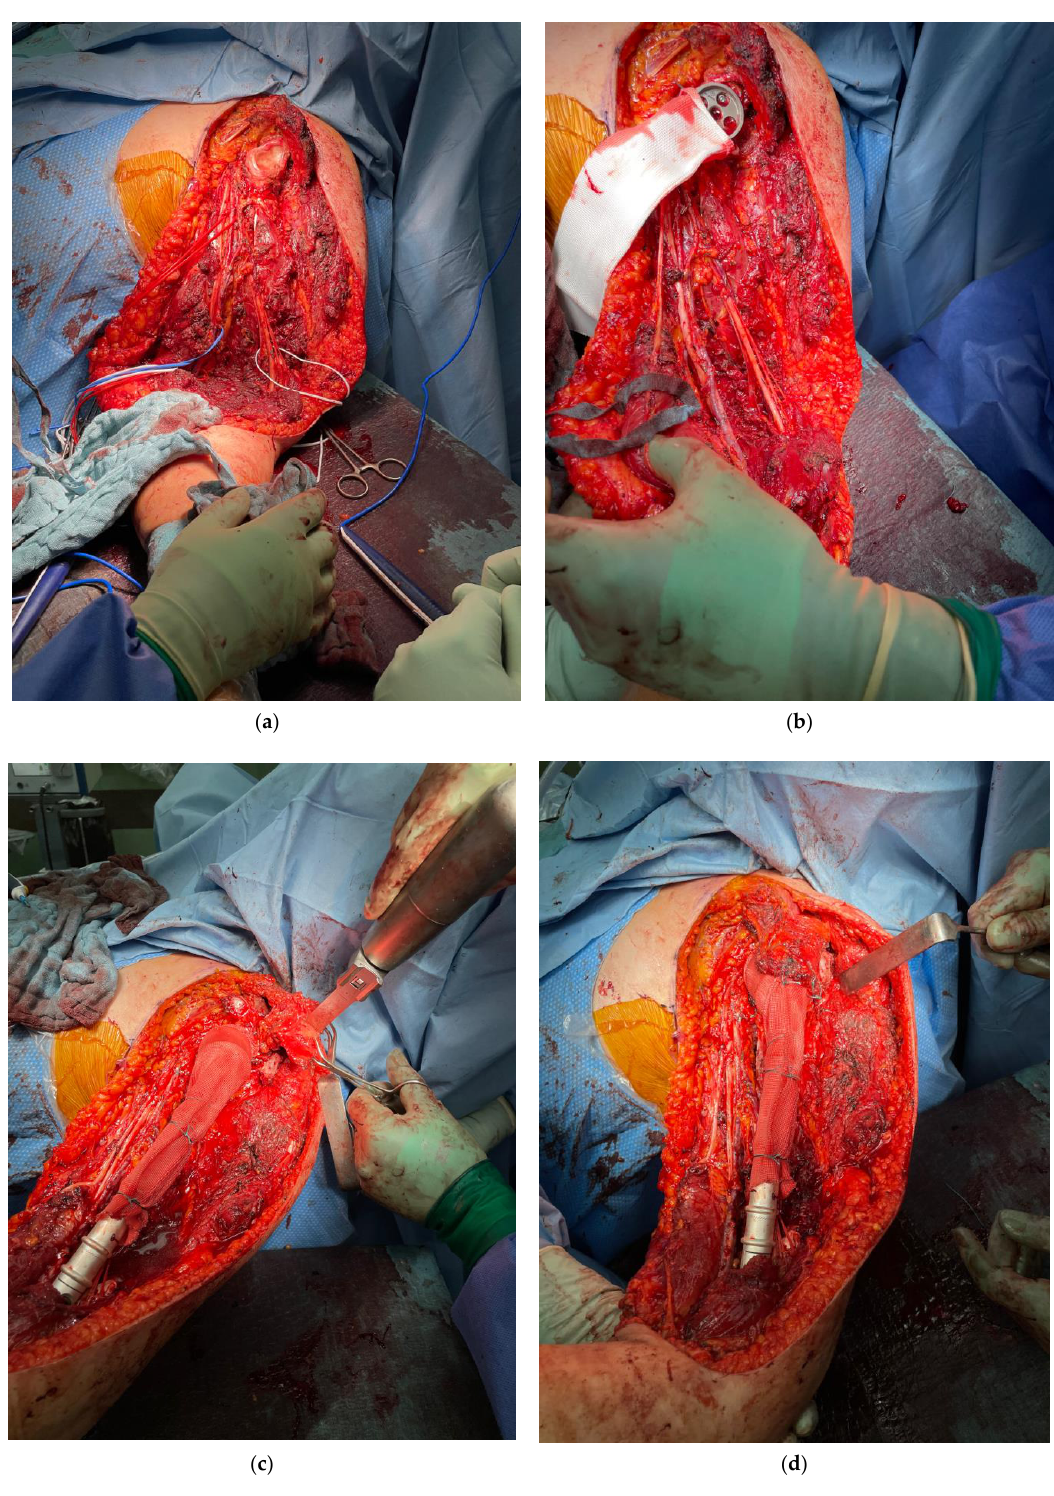
Figure 3. The Bateman-type soft tissue reconstruction with ( a ) the situs of the left upper extremity following glenohumeral dislocation and removal of the tumor with tagged neurovascular structures. ( b ) An attachment tube is fixed to the glenoid with non-absorbable No. 2 FibreWire ® . ( c ) The assembled modular megaprosthesis is shuttled through the attachment tube and fixated with several FibreWire ® sutures before the acromial attachment of the trapezius muscle is identified and freed from deltoid muscle fibres. ( d ) The trapezius is then transferred with its acromial attachment and fixed to the attachment tube at the lateral proximal humerus using several FibreWire ® sutures.